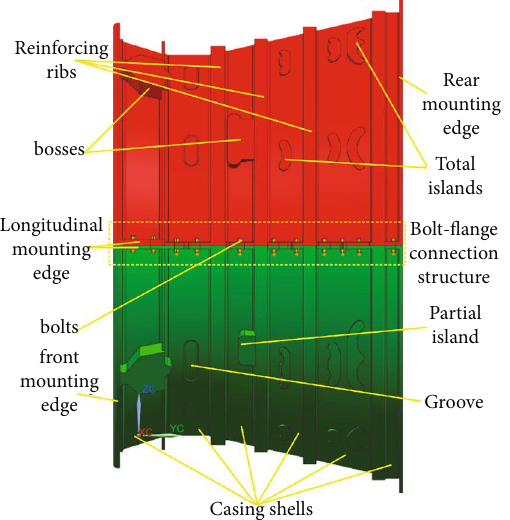
Figure 14: The structural features of two-stage casing assembly. The red and green parts represent the upper and lower casing,